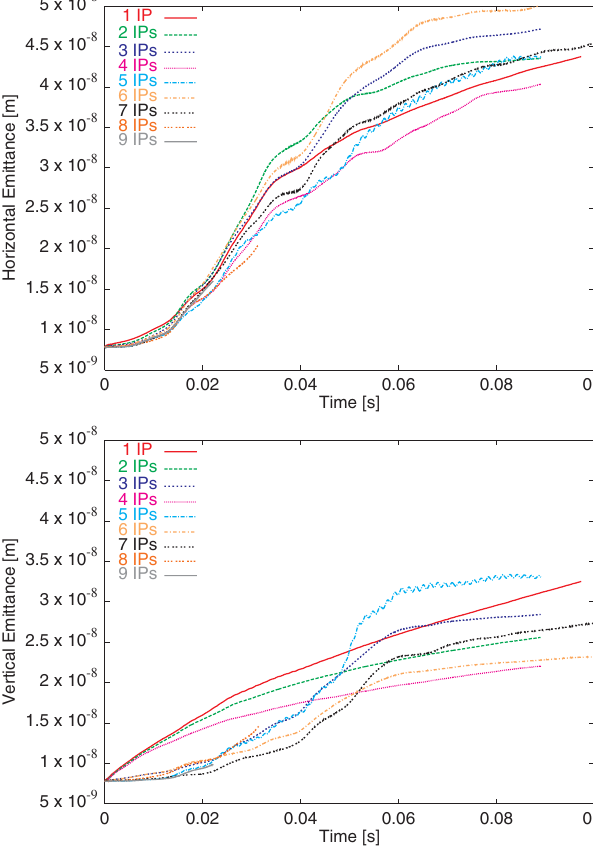
FIG. 4. (Color) Horizontal (top) and vertical (bottom) emittance as a function of time with different numbers of IPs, for the LHC at injection and an electron density (cid:2) (cid:2) 6 (cid:6) 10 11 m (cid:4) 3 .